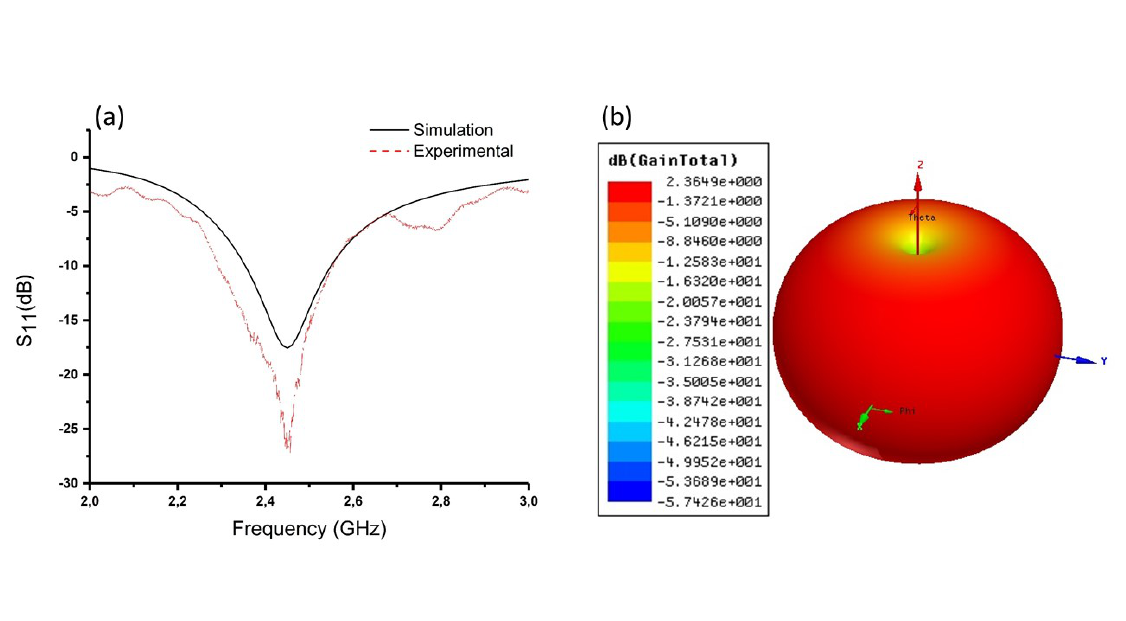
Figure 3. ( a ) Measured (red) and simulated (black) return loss (S 11 ) for the spiral antenna. ( b ) Three-dimensional (3D) plot of the spiral antenna’s gain in the x , y , and z directions obtained using ANSYS